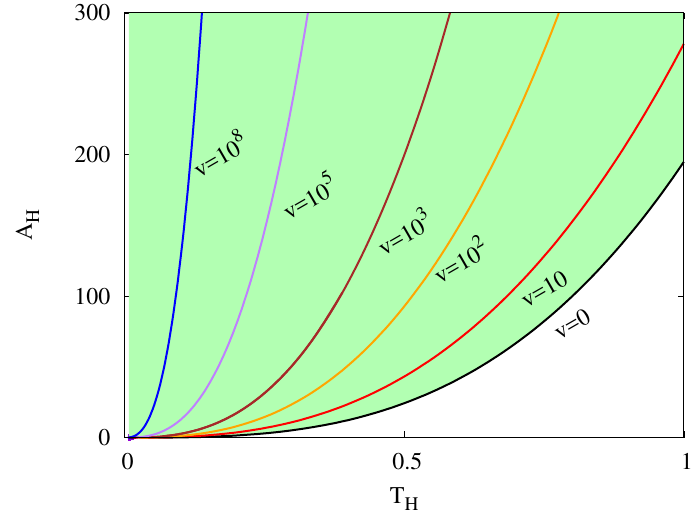
Figure 15. Area vs. temperature of static twisted black branes without electric charge. The lines represent families of black branes with constant twisting parameter v